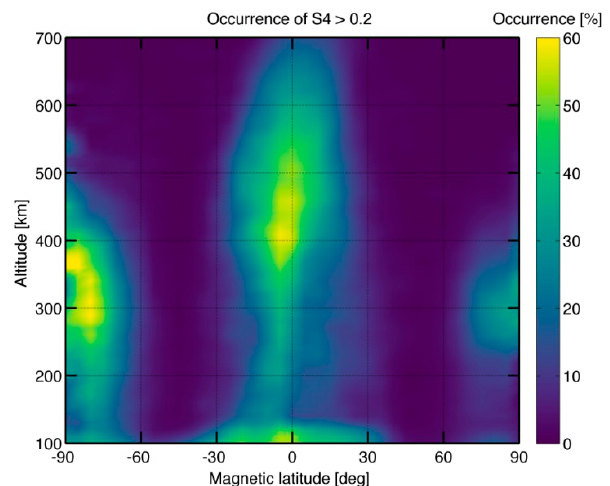
Figure 6. Occurrence rate of S4 > 0.2 as a function of magnetic latitude and height for local times from 19:00 to 23:00 LT observed by COSMIC in March 2014.